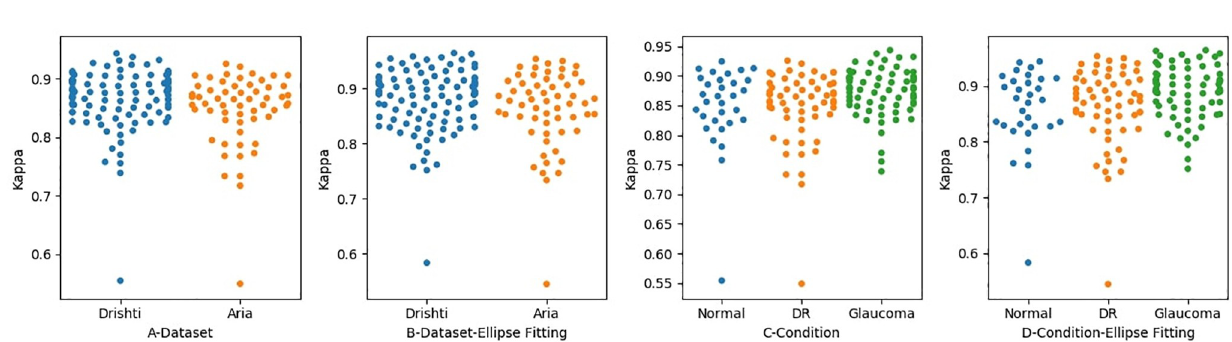
Fig 6. The level of agreement between the optometrists when identifying disc region. Figures A and B Show the Level of Agreement in each Dataset. Figures C and D show the Level of Agreement in Regard to Retinal Condition.